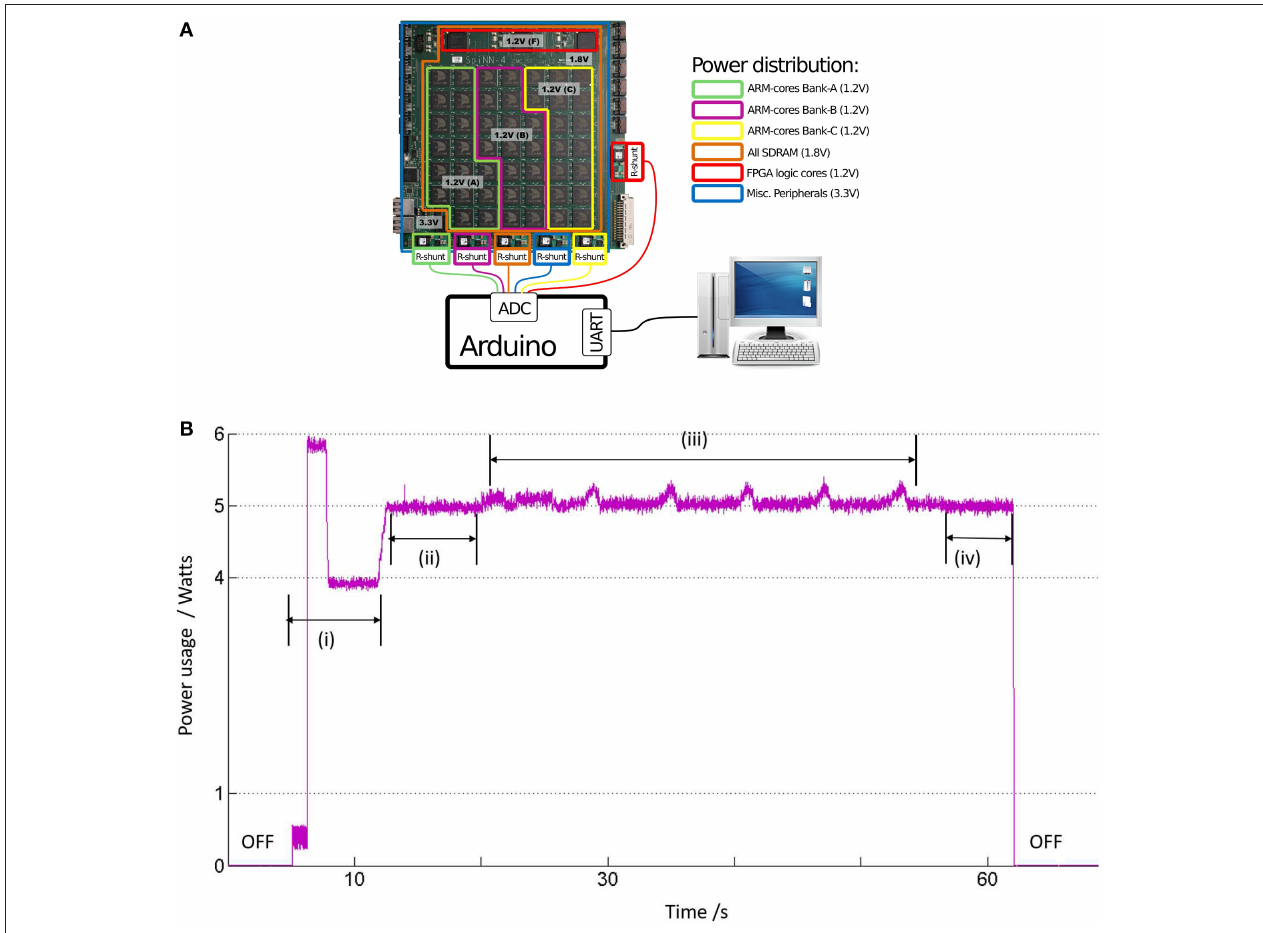
FIGURE 10 | (A) The SpiNNaker machine as a 48-node board, where each “node” is the SpiNNaker chip. The chips are divided into 3 “ARM-cores bank” based on their common sources of power supply via a DC/DC converter, each of 1.2 V. The resistors referred to as “R-shunt” are used to measure the current drawn from power supply by the various board components. The power consumed in Watts is calculated by the Arduino board, which is then communicated to a normal desktop computer via a serial port. (B) The instantaneous power consumption by the LGN model running on one SpiNNaker chip in ARM-cores Bank-A: (i) When the machine is powered, the average power consumption settles down to ≈ 4 W after a short period of activity. (ii) When the machine is booted, the average power consumption by the core bank increases to an average of 5 W. (iii) With start of simulation, the instantaneous power rides a slow modulating wave with peak to peak power of around 300 mW, corresponding to work done during neural computation by the cores. (iv) After completion of simulation, a drop in average power to around 5 W indicate a return to the boot state.